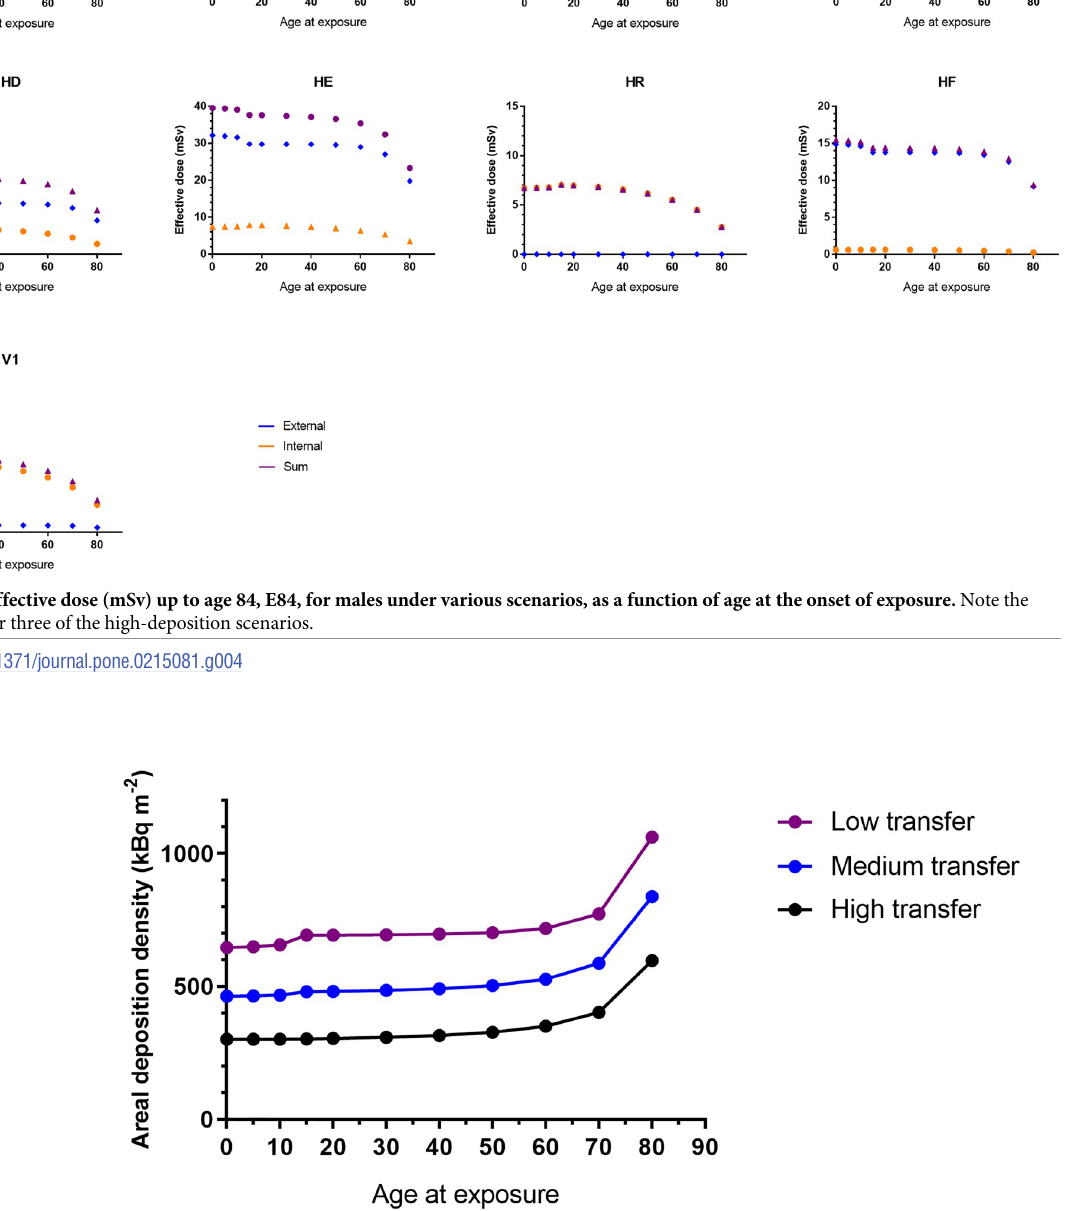
Fig 5. Areal deposition density of 137 Cs that would result in a cumulative effective dose of 100 mSv up to an age of 84 years as a function of age at the onset of exposure, assuming low-, medium- and high-transfer scenarios, corresponding to T of 1.0, 11.0 and 30.0, respectively. ag(max)